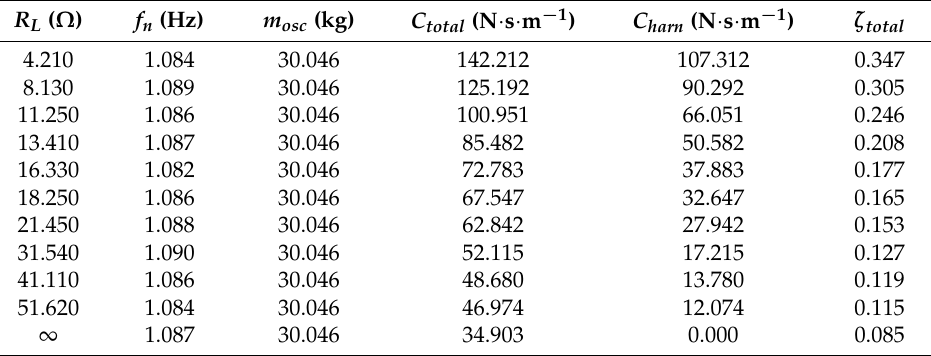
Table 2. Free decay test results by varying load resistances.